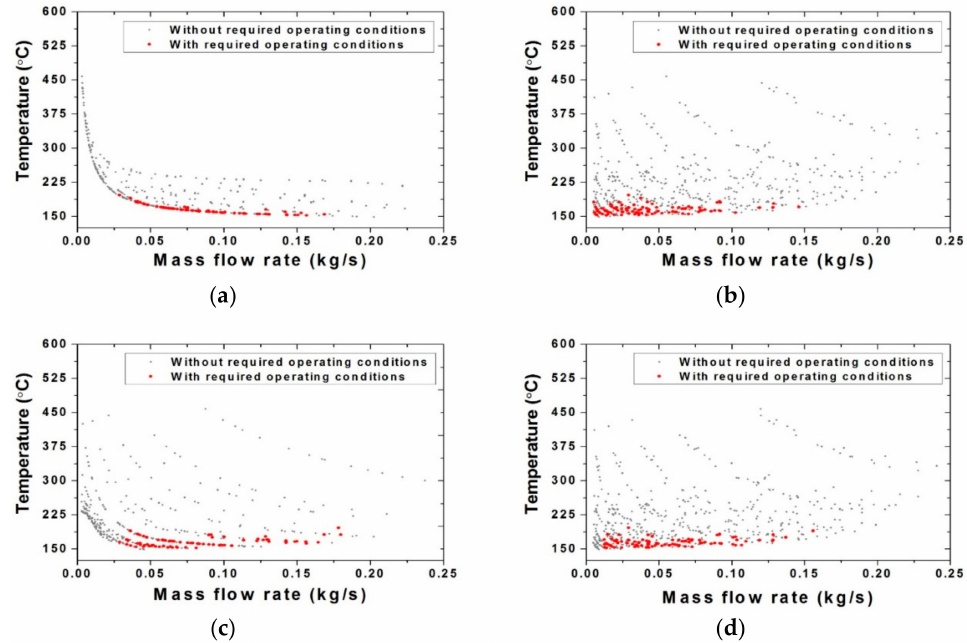
Figure 6. Stack outlet temperature according to flow rate of each valve (Absorption cooling capacity 2.5 kW). ( a ) TM valve; ( b ) IC valve; ( c ) CHP valve; ( d ) CCP